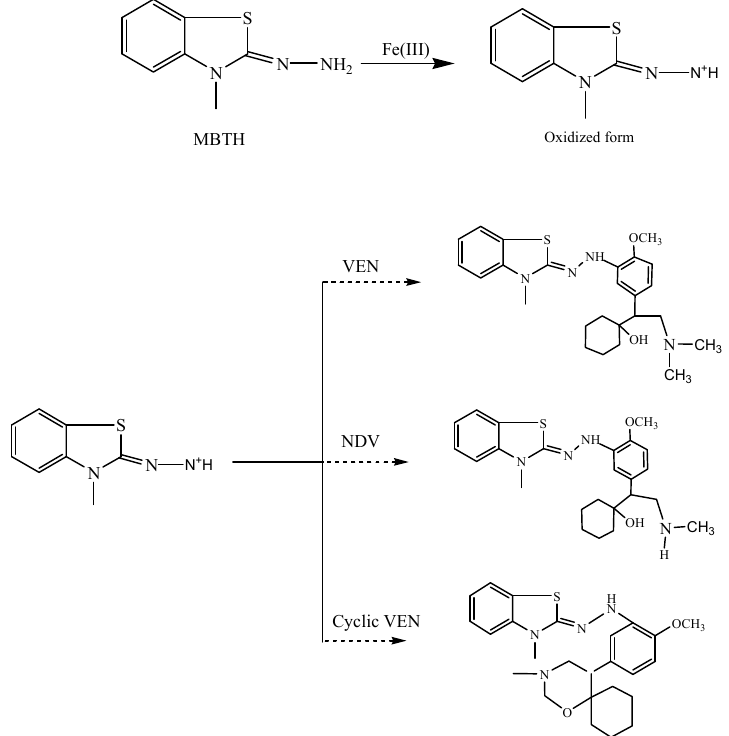
Figure 2. Proposed reaction mechanism / s producing the spectrophotometrically detectable colored complexes.